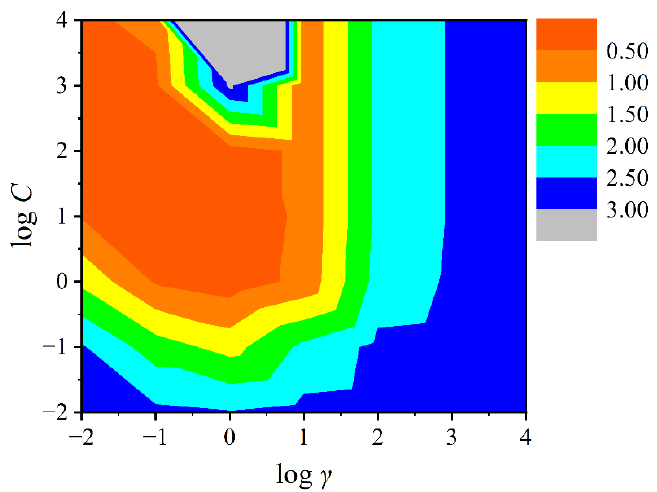
Figure 4. Contour map of the combination of hyperparameter ( γ ) and penalty factor ( C ) in the SVM model.